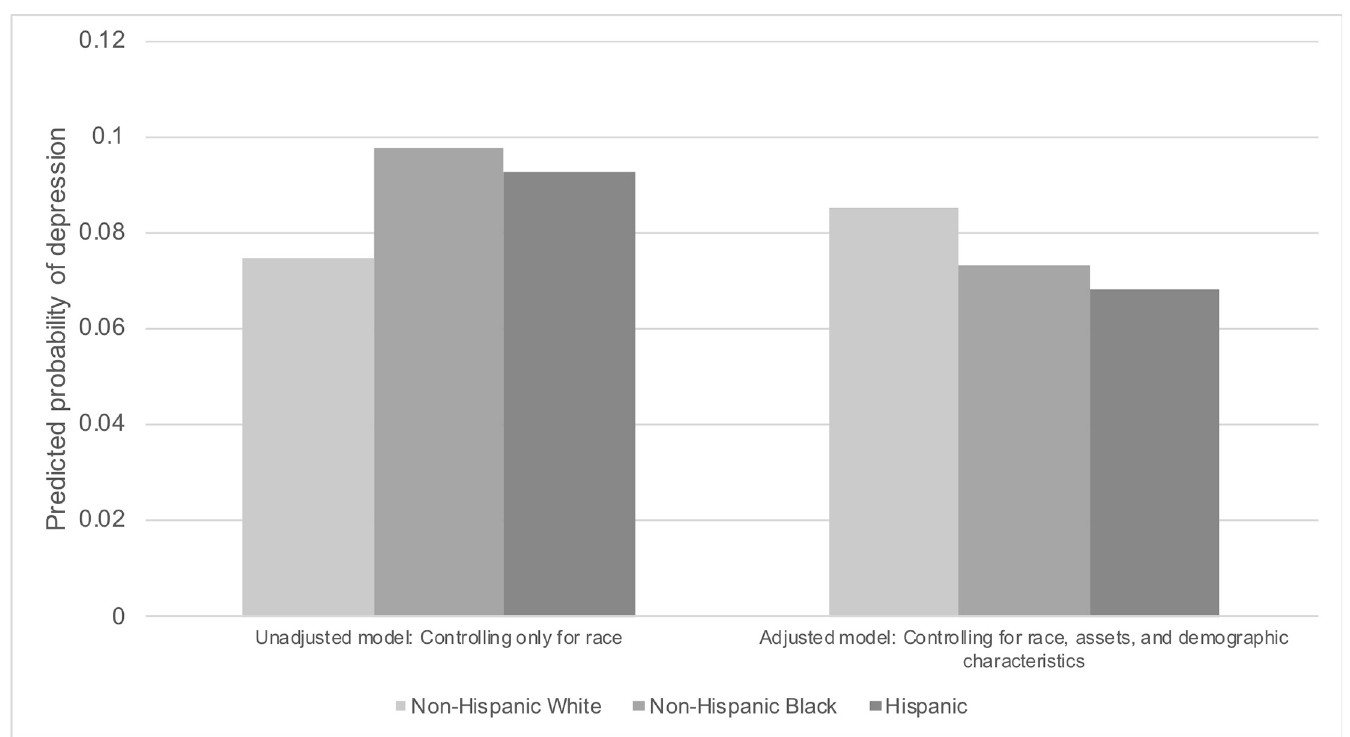
Fig 5. Predicted probability of depression across race/ethnicity using unadjusted and adjusted models in U.S. adults (N = 26,382). The National Health and Nutrition Examination Survey (NHANES) 2007–2016. Weighted to the U.S. population. Unadjusted model controlled only for race/ethnicity and NHANES cohort wave. Adjusted model controlled for race/ethnicity, age, gender, education, marital status, household income, home ownership, household size, and NHANES cohort wave. Probable depression defined by Patient Health Questionnaire-9 (PHQ-9) cutoff of � 10.